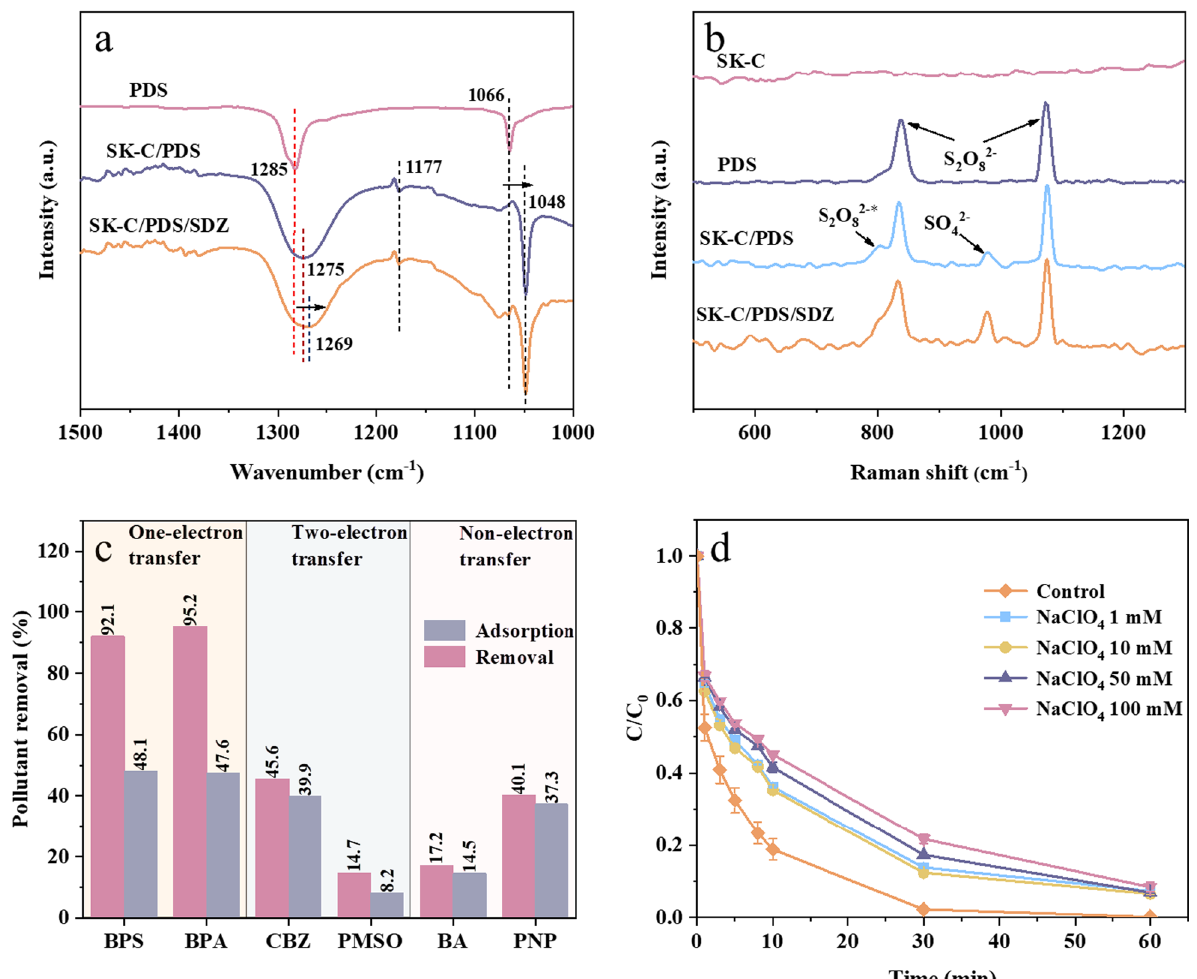
Fig. 4 ATR-FTIR spectra ( a ) of various SK-C suspension. In situ Raman spectra ( b ) of PDS/SK-C/SDZ, PDS/SK-C, PDS and SK-C in the liquid solution. Removal ( c ) of different pollutants in SK-C/PDS system. Effects of ionic strength [NaClO 4 ] ( d ) on the removal of SDZ in SK-C/PDS system. Experimental conditions: